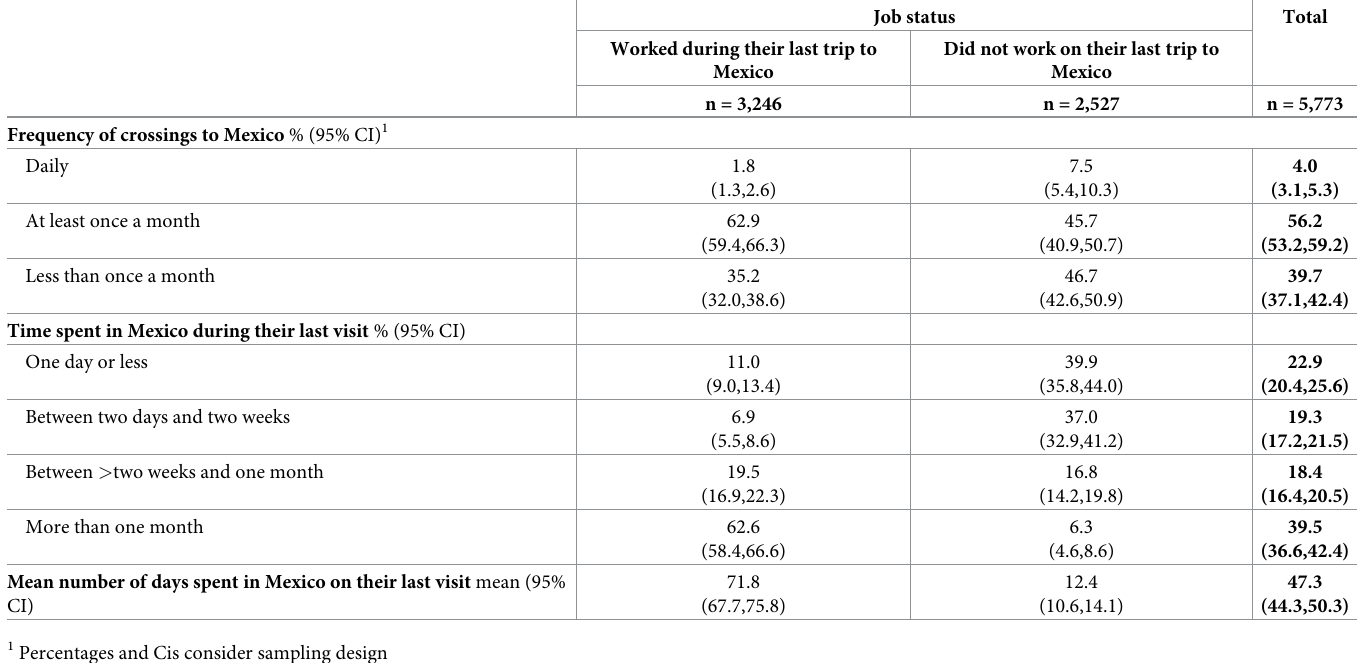
Table 2. Mobility characteristics of Guatemalans living in Guatemala, by job status.